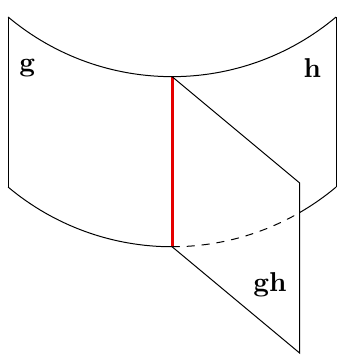
Figure 1 . A junction (in red) where three 0-form symmetry defects of type g , h , gh meet in codimension 2. This con(cid:12)guration is generic in spacetime dimension 2 and above. These junctions encode the group law of the 0-form